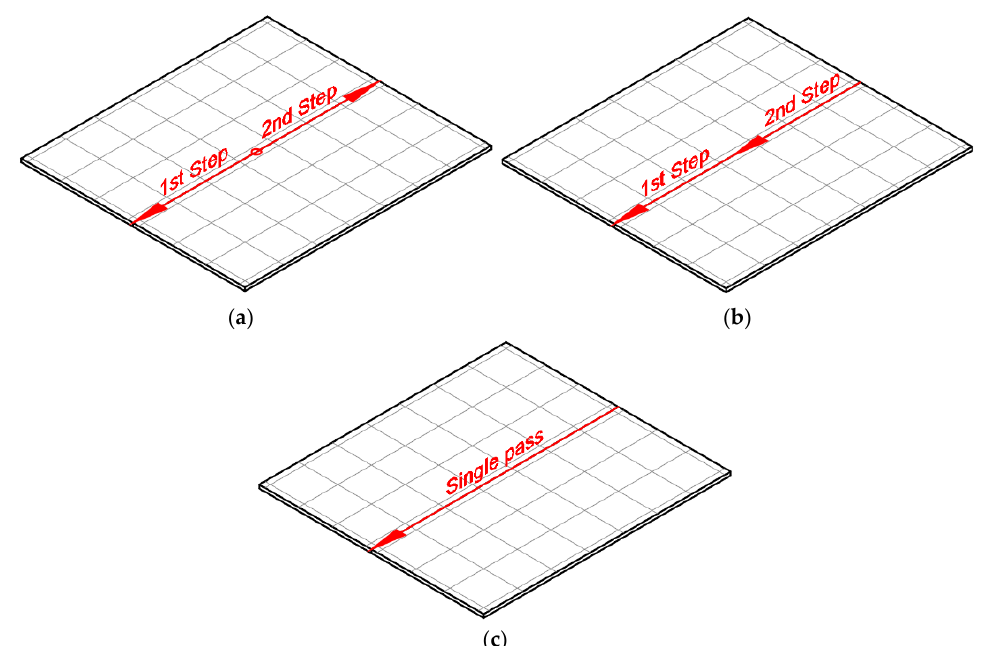
Figure 7. Butt-joint welding sequences, ( a ) symmetrical method (SM), ( b ) backward method (BM), and ( c ) single-pass method (SP).